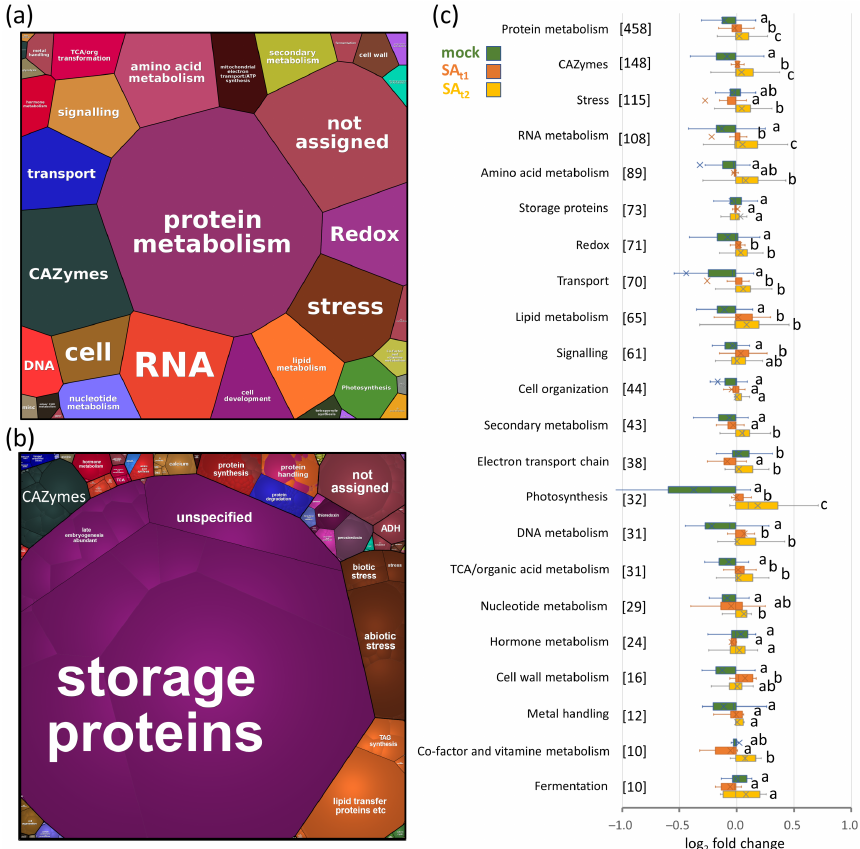
Figure 3. The composition of seed proteome. ( a , b ) Visualization of the seed proteome in the Pro- teoMap based on 1796 quantified proteins and the annotations of their corresponding Arabidopsis orthologs. ( a ) Expected functions of quantified proteins. The category size is proportional to the number of identified proteins. ( b ) Estimated protein content in the seeds of mock-treated plants. The category size is proportional to the estimated protein abundance. ( c ) Expected effects on 22 metabolic pathways based on the observed differences in protein abundance. Box plot representation of log2 fold changes in protein abundances including median (line) and mean values (cross). Numbers in brackets represent the number of proteins in the corresponding category. The letters represent signifi- cant differences ( p < 0.05, Kruskal–Wallis and Conover’s test, p < 0.05). For details, see